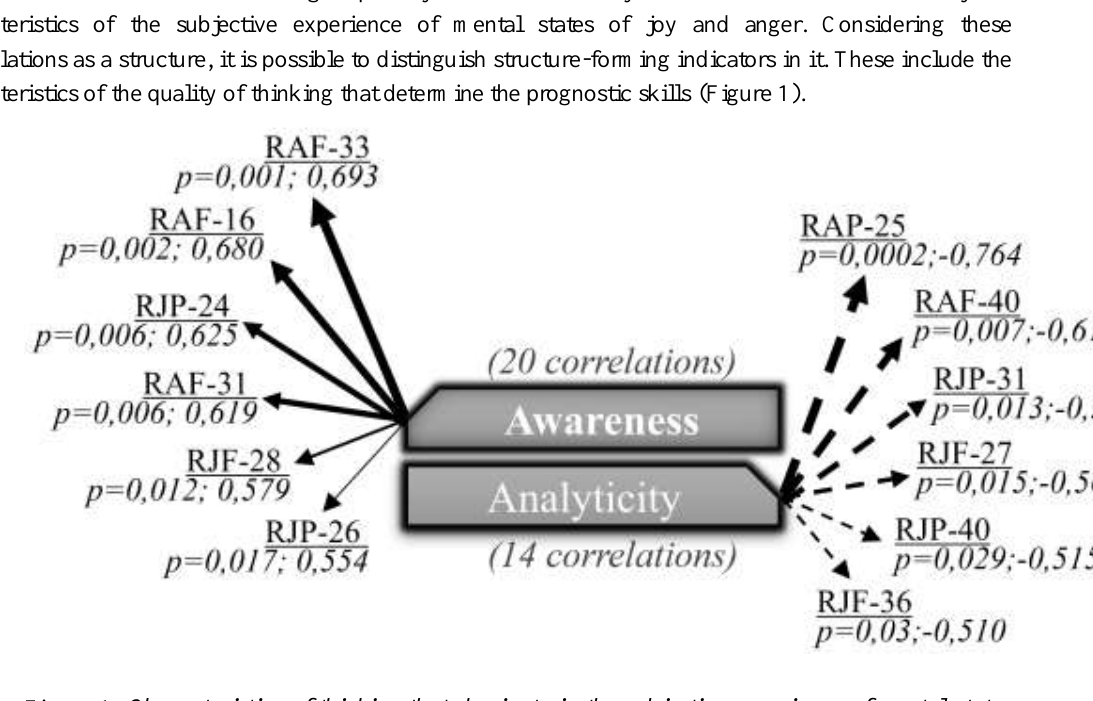
Figure 1. Characteristics of thinking that dominate in the subjective experience of mental states (general picture